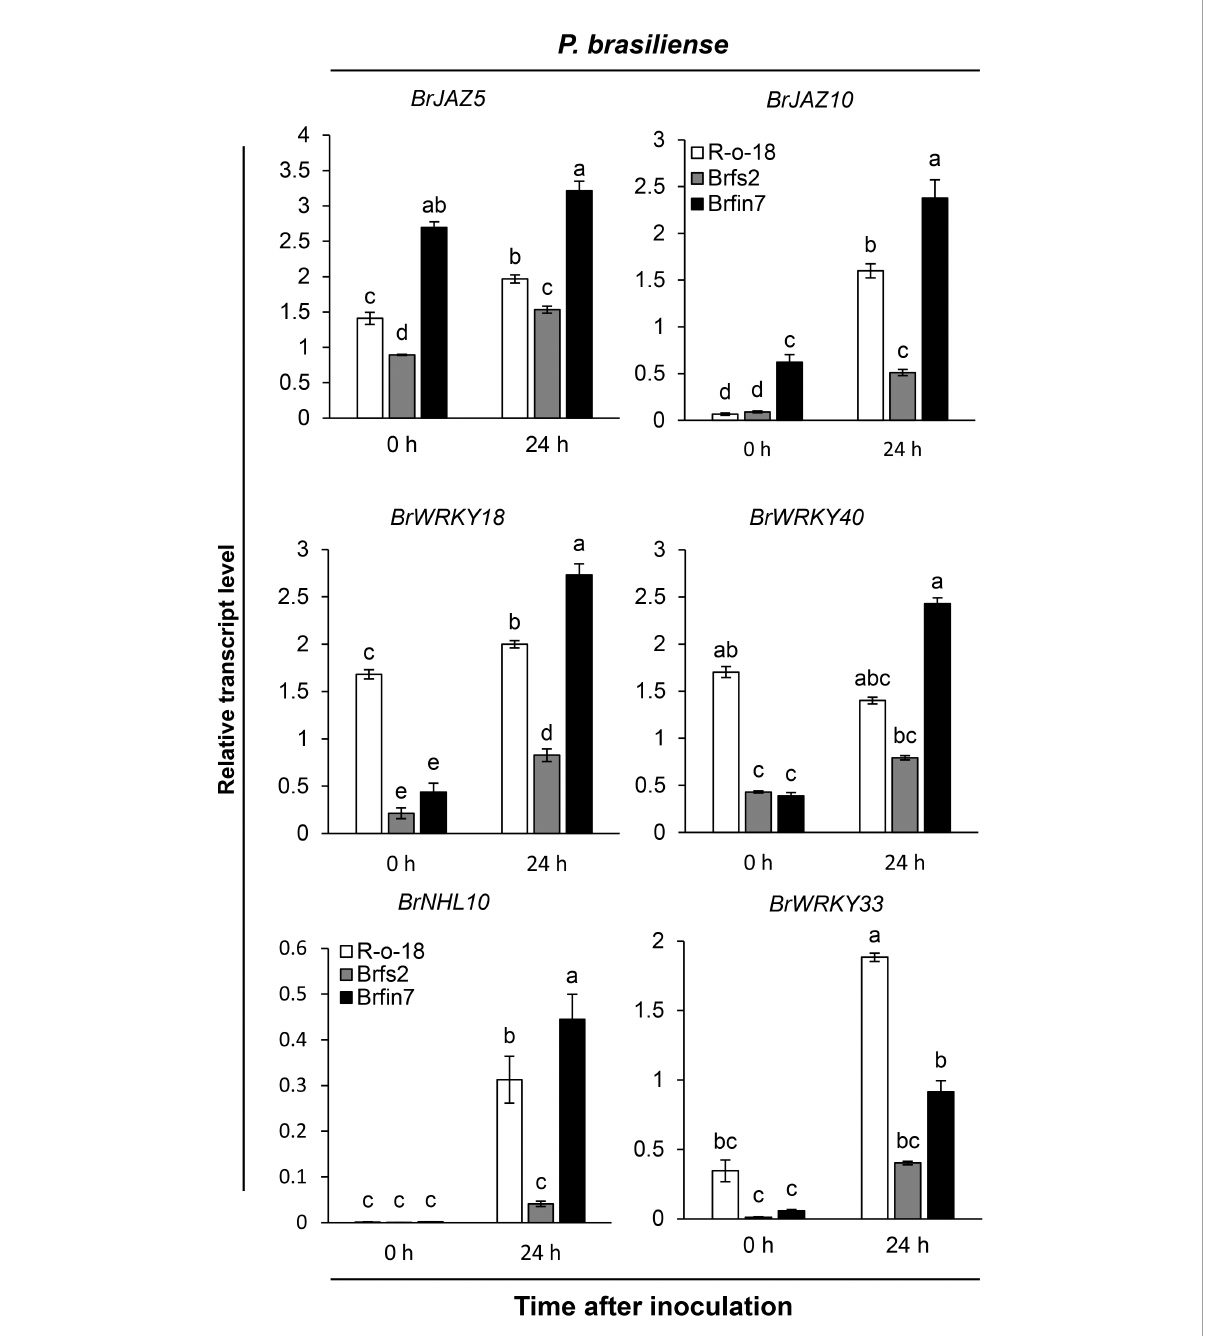
FIGURE 4 Transcript levels of pathogen-induced genes in R-o-18, Br fs2, and Br fi n7 plants. Four-week-old B. rapa plants were inoculated with P. brasiliense and sampled at 24 h post-inoculation. The BrJAZ25 , BrJAZ10 , BrWRKY40 , BrWRKY18 , BrNHL10 and BrWRKY33 transcript levels were determined using qRT-PCR. Gene transcript levels were normalized to the BrACT2 transcript levels. Error bars represent the standard deviation of three replicates. Similar results were obtained in at least two independent experiments. Different letters indicate signi fi cant differences among plant genotypes ( a = 0.01, one-way ANOVA and Duncan test; SPSS